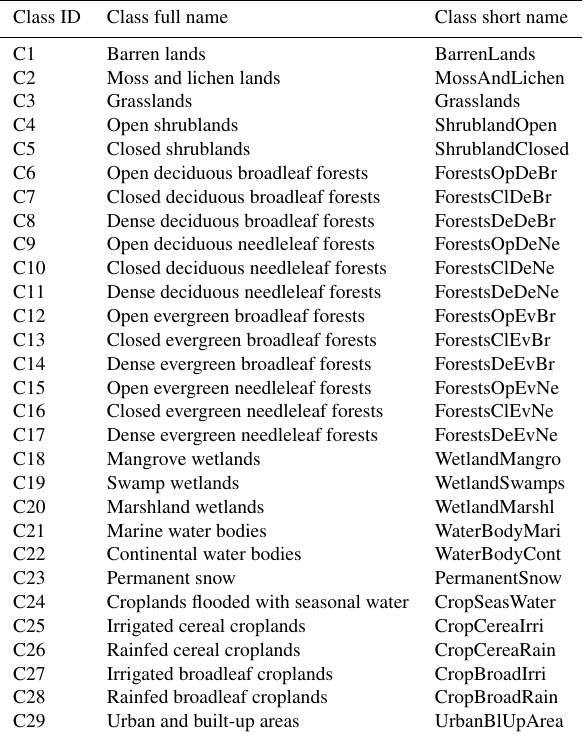
Table 3. Description of the full name and short name of each LULC class in the TimeSpec4LULC